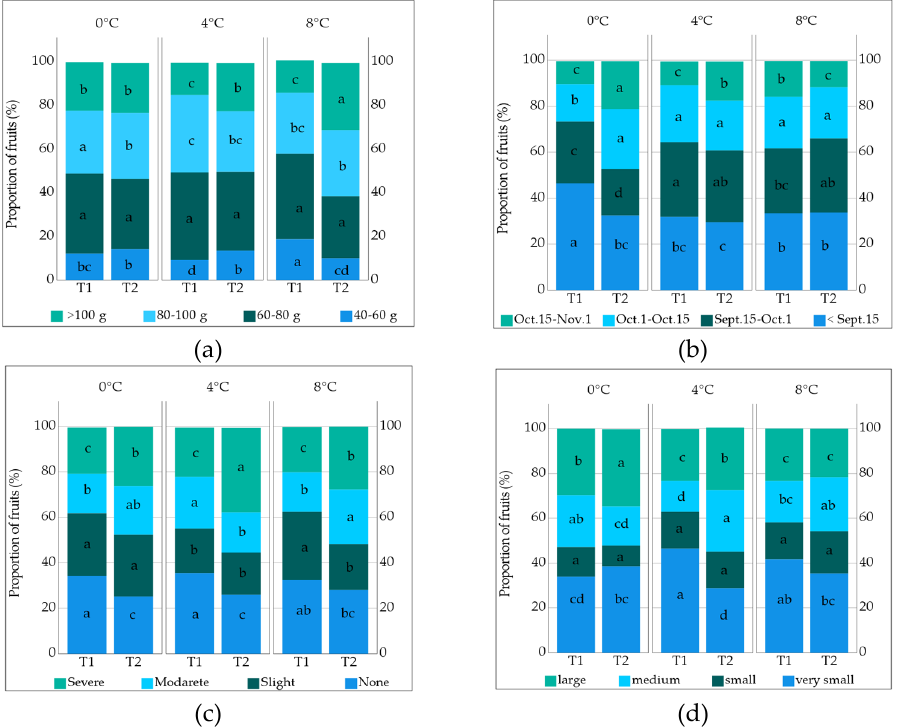
Figure 4. Proportion of fruits (%) according to ( a ) time of ripening; ( b ) fruit weight; ( c ) ostiole damage; ( d ) fruit cavity at interaction different storage temperature × pollination frequency. Different small letters indicate a significant difference according to Duncan test, p < 0.05 (T1: 4-day intervals, T2: 8-day intervals pollination, Sept.: September, Oct.: October, Nov.: Novermber ).